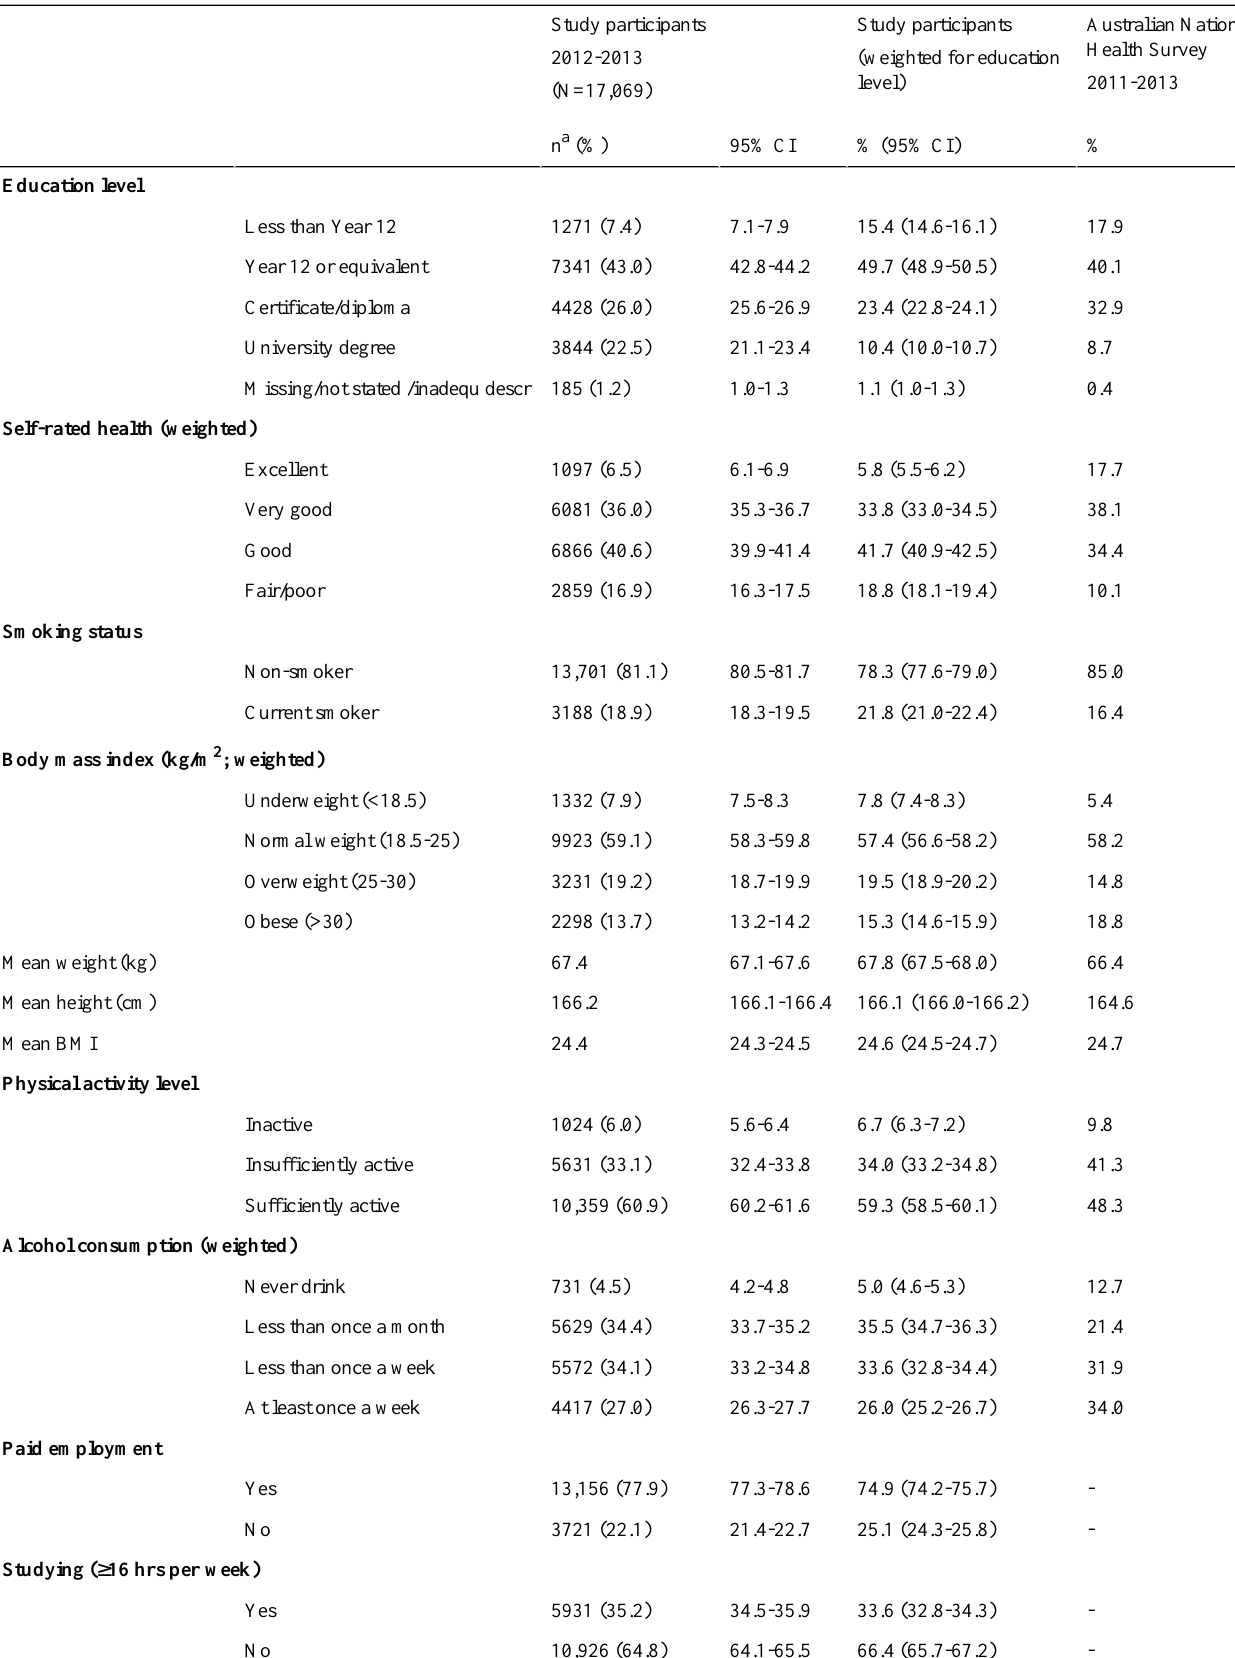
Table 2. Comparison of education level and lifestyle characteristics of women aged 18-23 years, recruited using the Internet and social networking sites, with the 2011-2012 Australian National Health